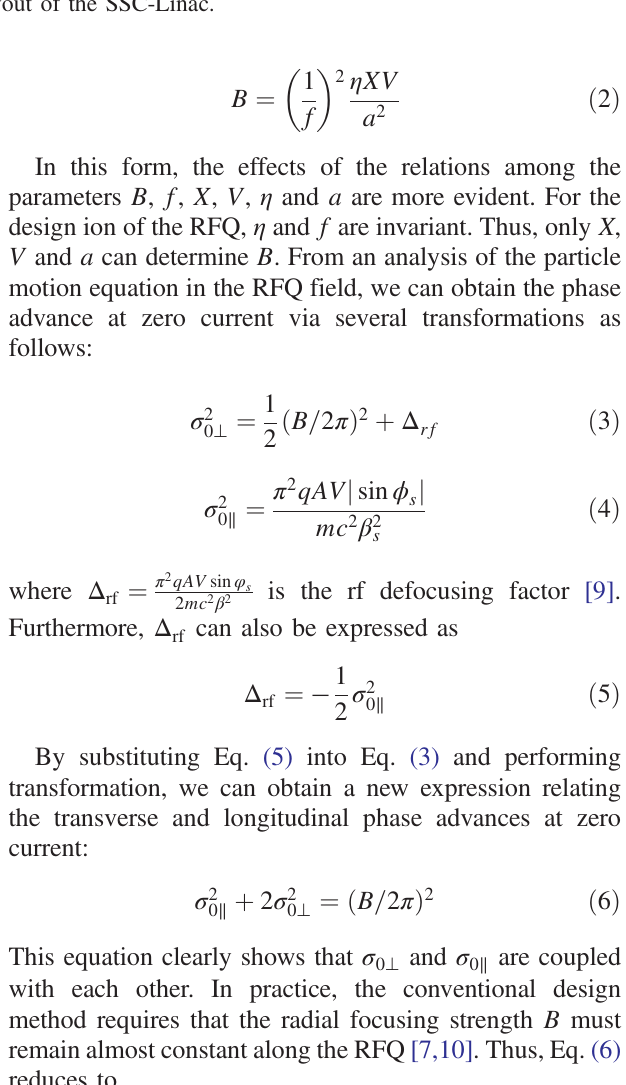
FIG. 1. The general layout of the